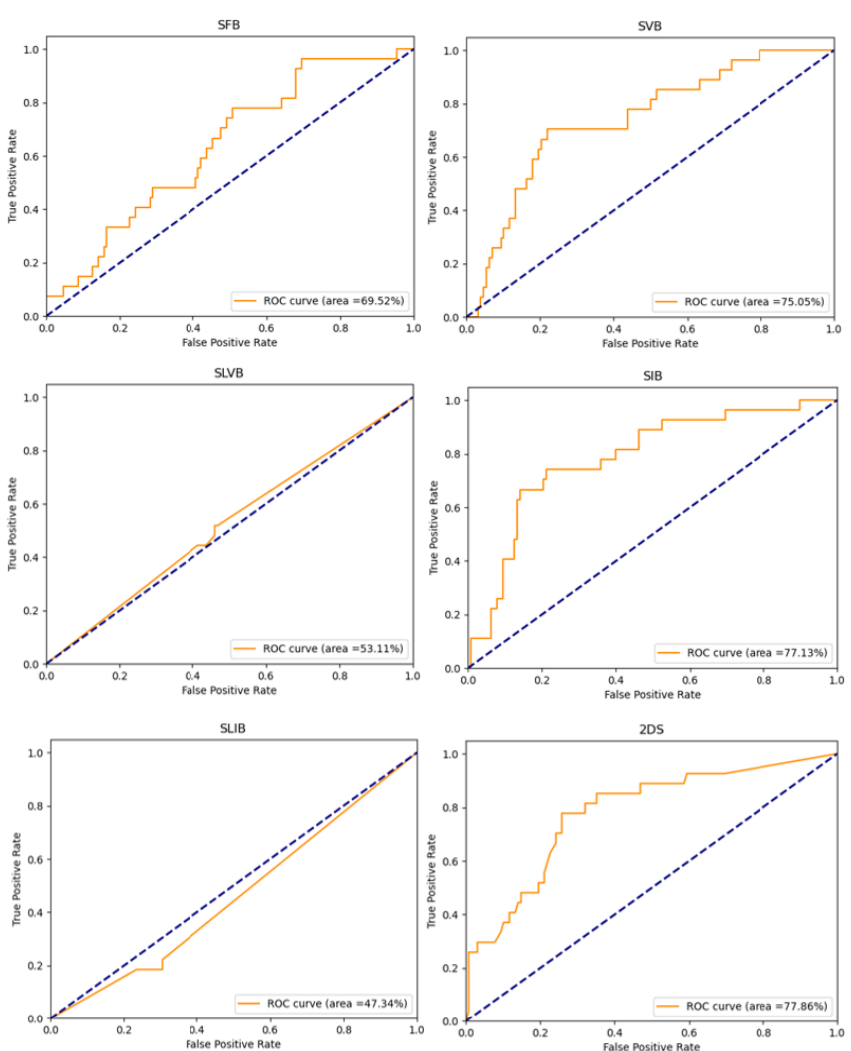
Figure 5. ROC curves of the implemented experiments. The title of each plot suggests the tumor bounding option that is used. Figure 6 shows the precision-recall curves of the implemented experiments that re- port the tradeoff between the precision and recall for different thresholds. When the